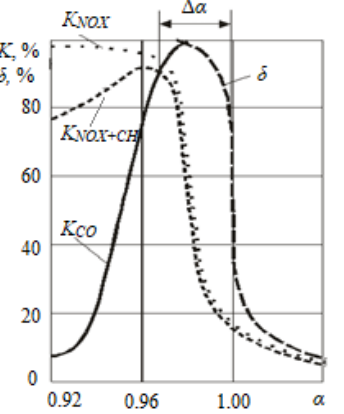
Figure 3. The dependence of the conversion ratio K (%) of the catalytic converter on the excess air ratio, α ; δ is the voltage at the working terminals of the λ probe (V); Δ α is the reference displacement made automatically by the electronic control unit of the ICE; К NOX is the efficiency of processing nitrogen oxides NOX by the catalytic converter (%); K NOX+CH is the efficiency of processing nitrogen oxides NOX and hydrocarbons CH by the catalytic converter (%); K CO is the efficiency of processing carbon oxides CO by the catalytic converter